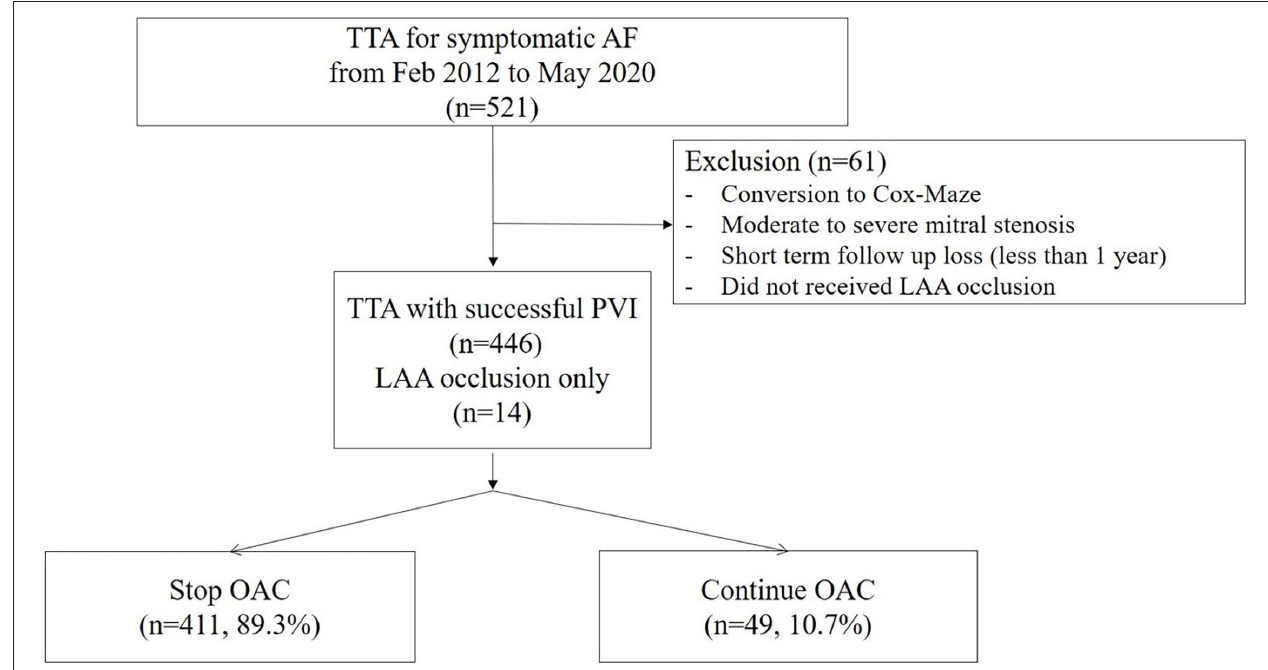
FIGURE 1 | Patient flow